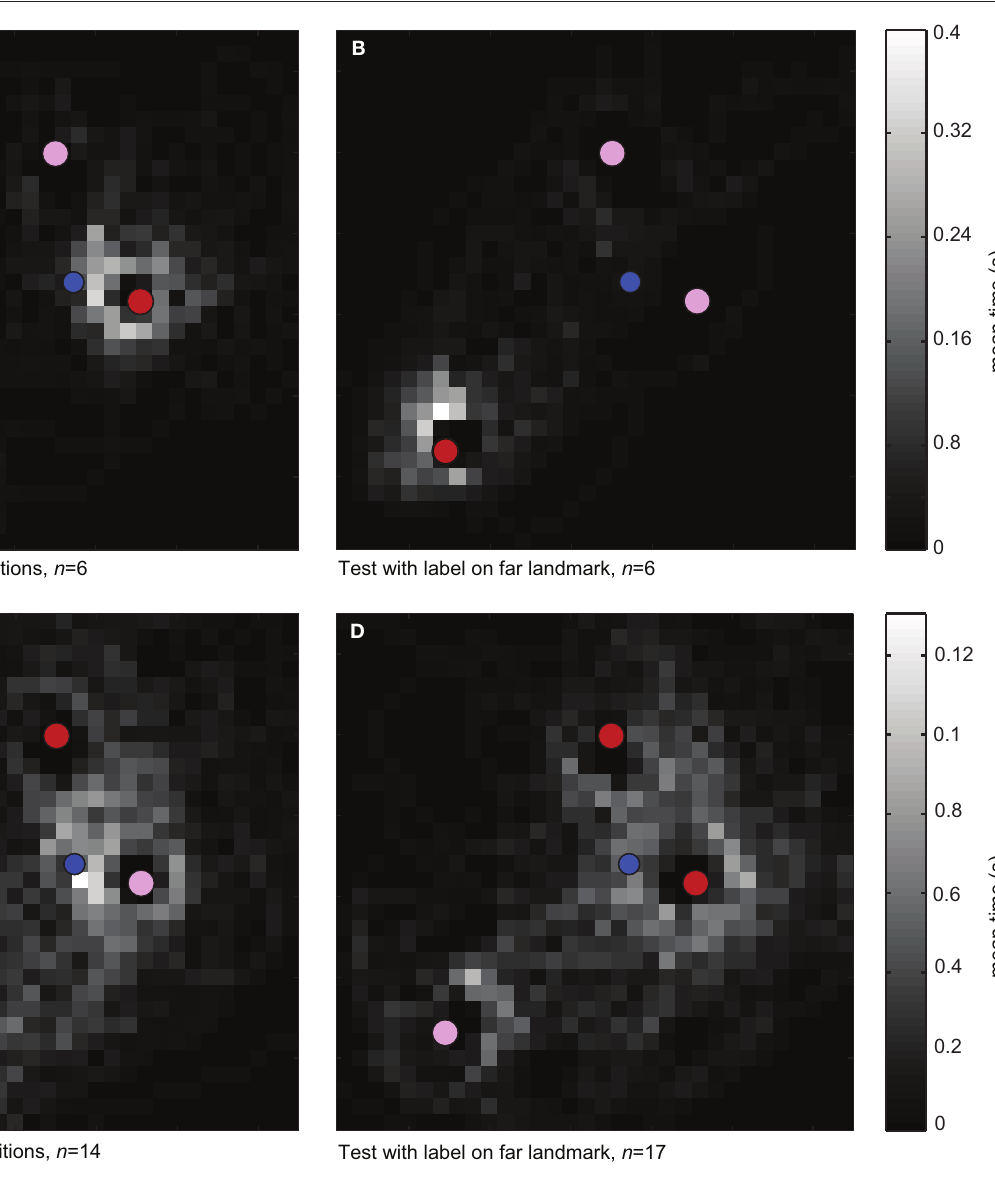
(A) homogenously red (red dot) and the other two landmarks were covered with a random dot texture ( n = 6 flights; N = 5 bees) or (C) had a random dot pattern (rose dot, n = 14 flights, N = 11 bees) and the other two were homogenously red. During cue-conflicting tests (B,D) , the landmark texture was exchanged between the near and the far landmark (feeder removed) to test the influence of landmark texture on the search location [ (B) , n = 6 flights, N = 5 bees; (D) , n = 17 flights, N =